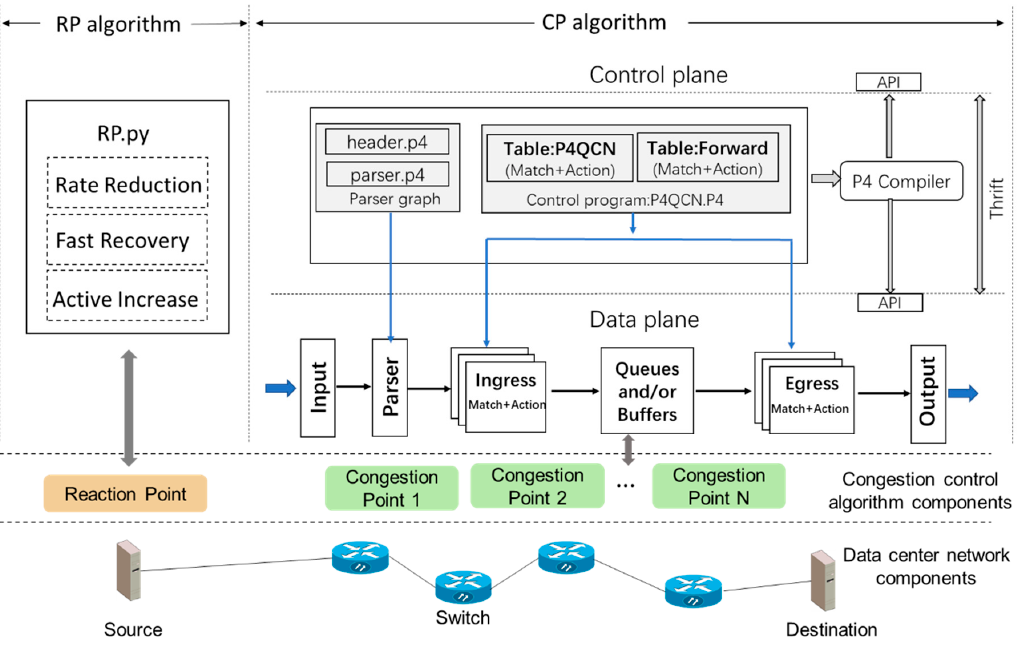
Figure 9. P4QCN system implementation.